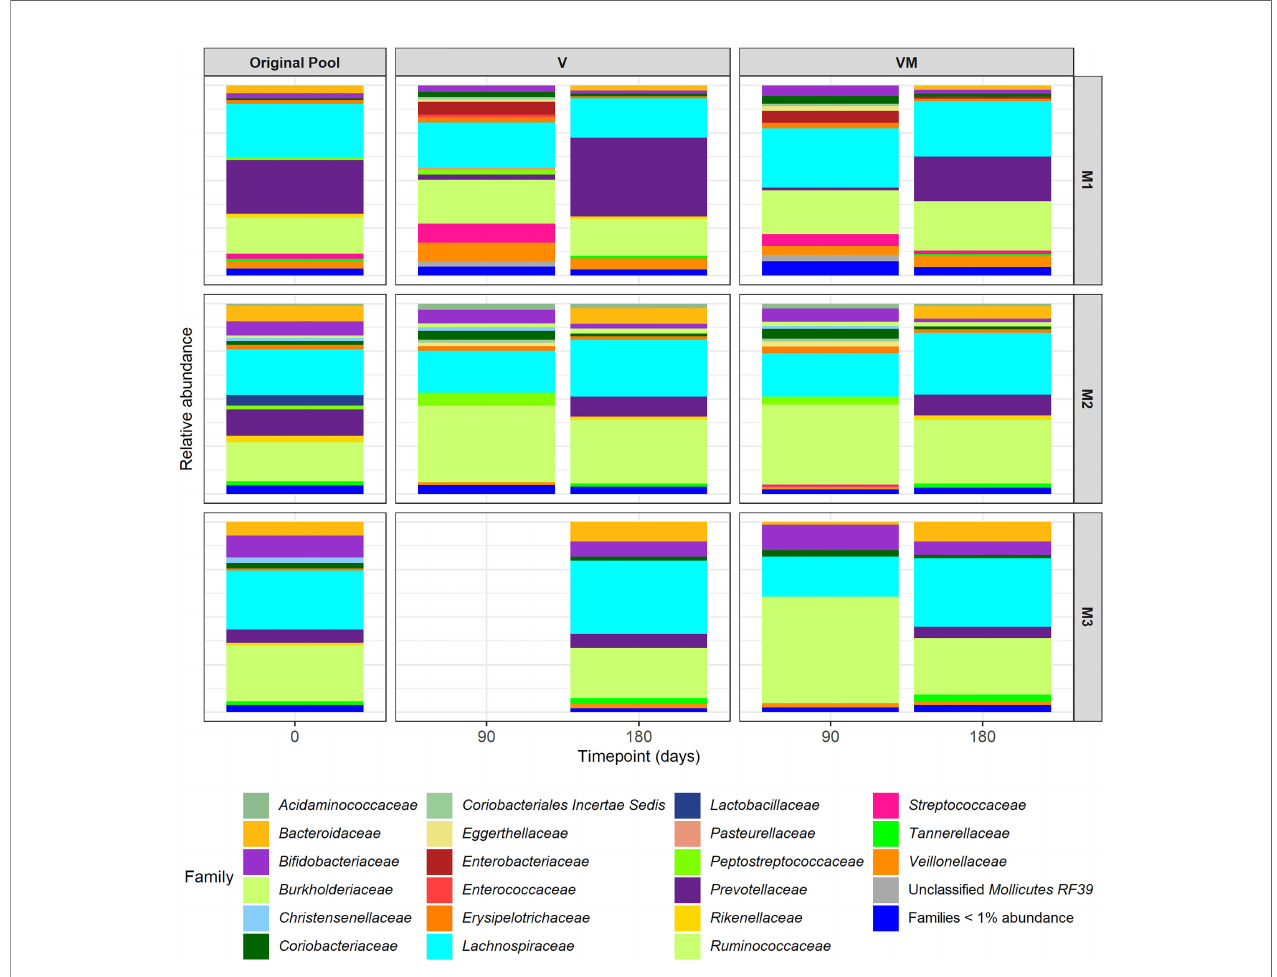
FIGURE 6 | Relative abundances of bacterial taxonomical composition at the family level of original pool and capsules using Vivapur-101 ® (V) or Vivapur-101 ® +magnesium stearate (VM) of the three experiment samples (M1, M2, and M3). The analysis was performed at 3 months (90 days) and 6 months (180 days) in the 3 individual samples analyzed. The M3 V capsules at 3 months were excluded due to low sequence